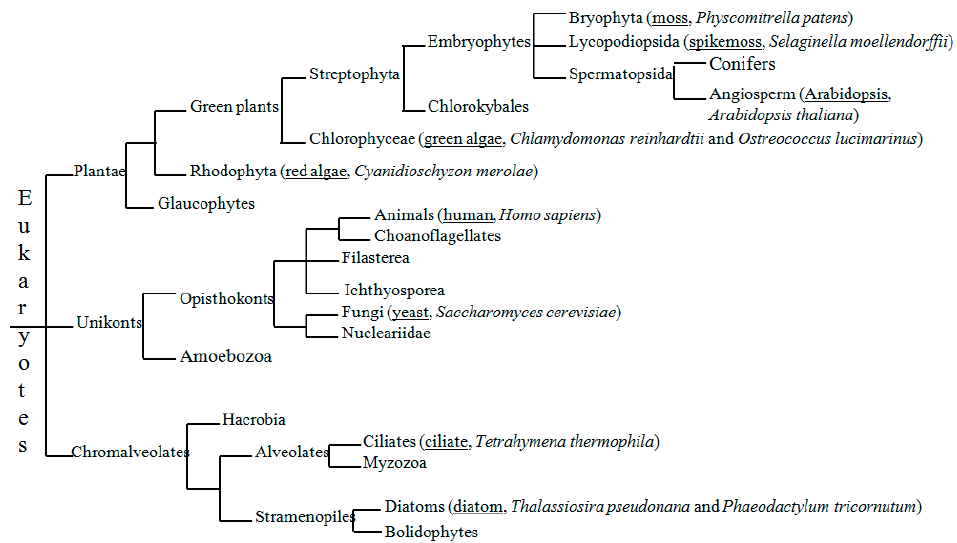
Figure 2. The phylogenetic relations among the 11 species investigated in our study. The common names and scientific names are listed in parentheses close to the relevant clade names in the phylogenetic tree. The common names are all underlined. The phylogenetic tree is constructed according to Tree of Life Web Project (http://tolweb.org/tree/phylogeny.html).